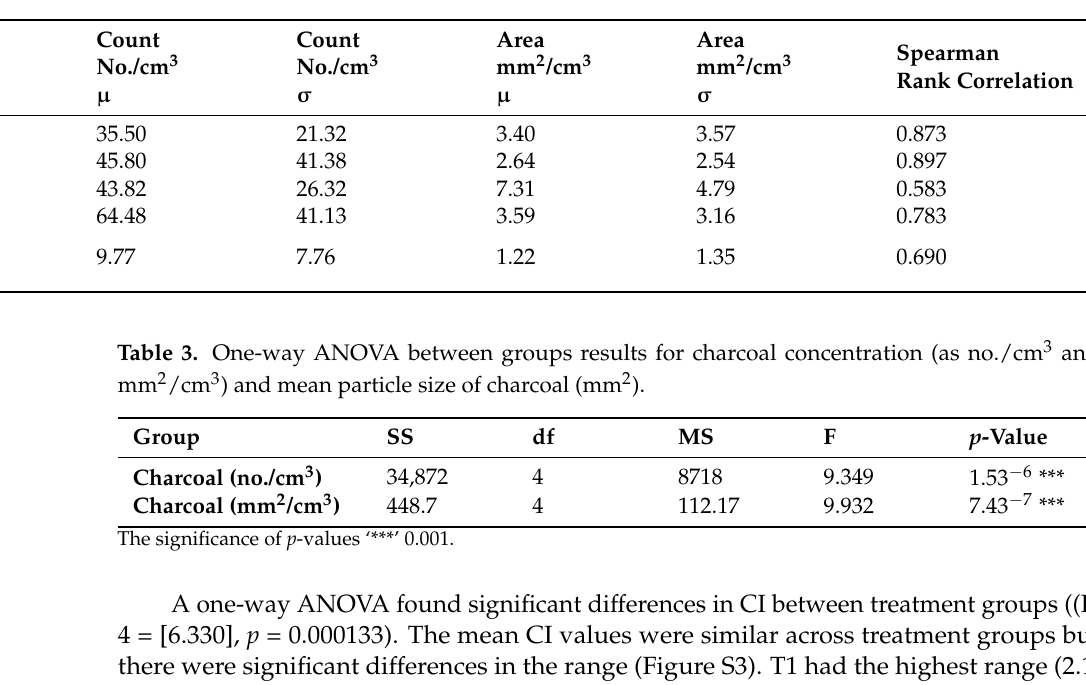
Figure 1. The results of the five treatment groups. CHAR count (No./cm 3 /yr), CHAR area (mm 2 /cm 3 /yr), and CI. Treatment groups are represented by colour. The grey shading in CI repre- sents the minimum and maximum CI values. Table 2. Group average charcoal count (no./cm 3 ), area (mm 2 /cm 3 ), and mean size (mm 2 ) of charcoal particles from treatment groups from the WB3 core. The Spearman range correlation coefficient was calculated between charcoal count and area for each treatment.